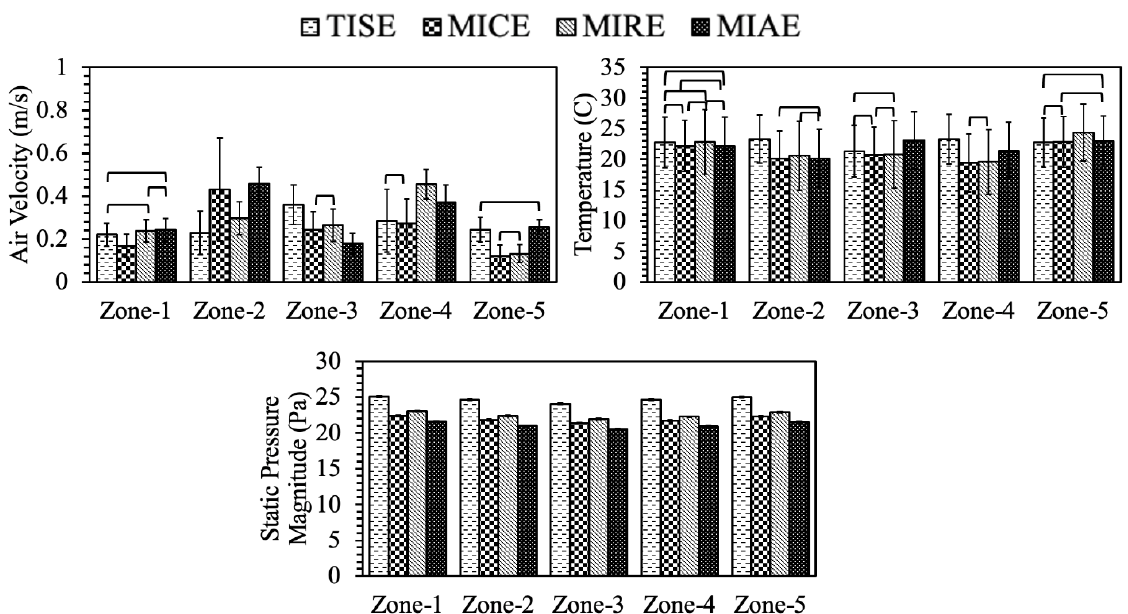
Figure 11. Environmental parameters of hen-occupied zones at Plane I in four models. Crossbars indicate No statistically significant differences at 95% family-wise confidence level. Error bars stand for the standard deviation.